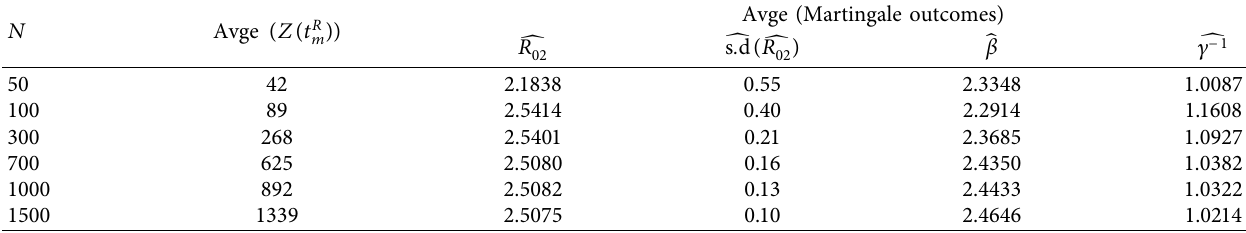
Table 1: Results of simulation study I with R realizations.